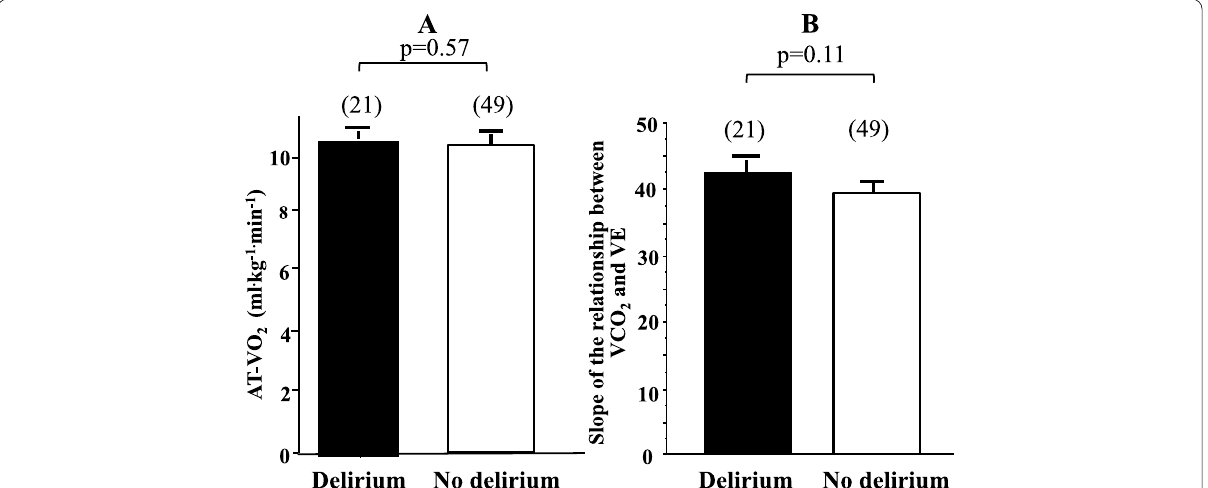
Fig. 2 Anaerobic threshold oxygen uptake (AT-VO2) ( A ) and the slope of the relationship between carbon dioxide output (VCO2) and minute ventilation (VE) ( B ) in the presence and absence of delirium. Data are expressed as